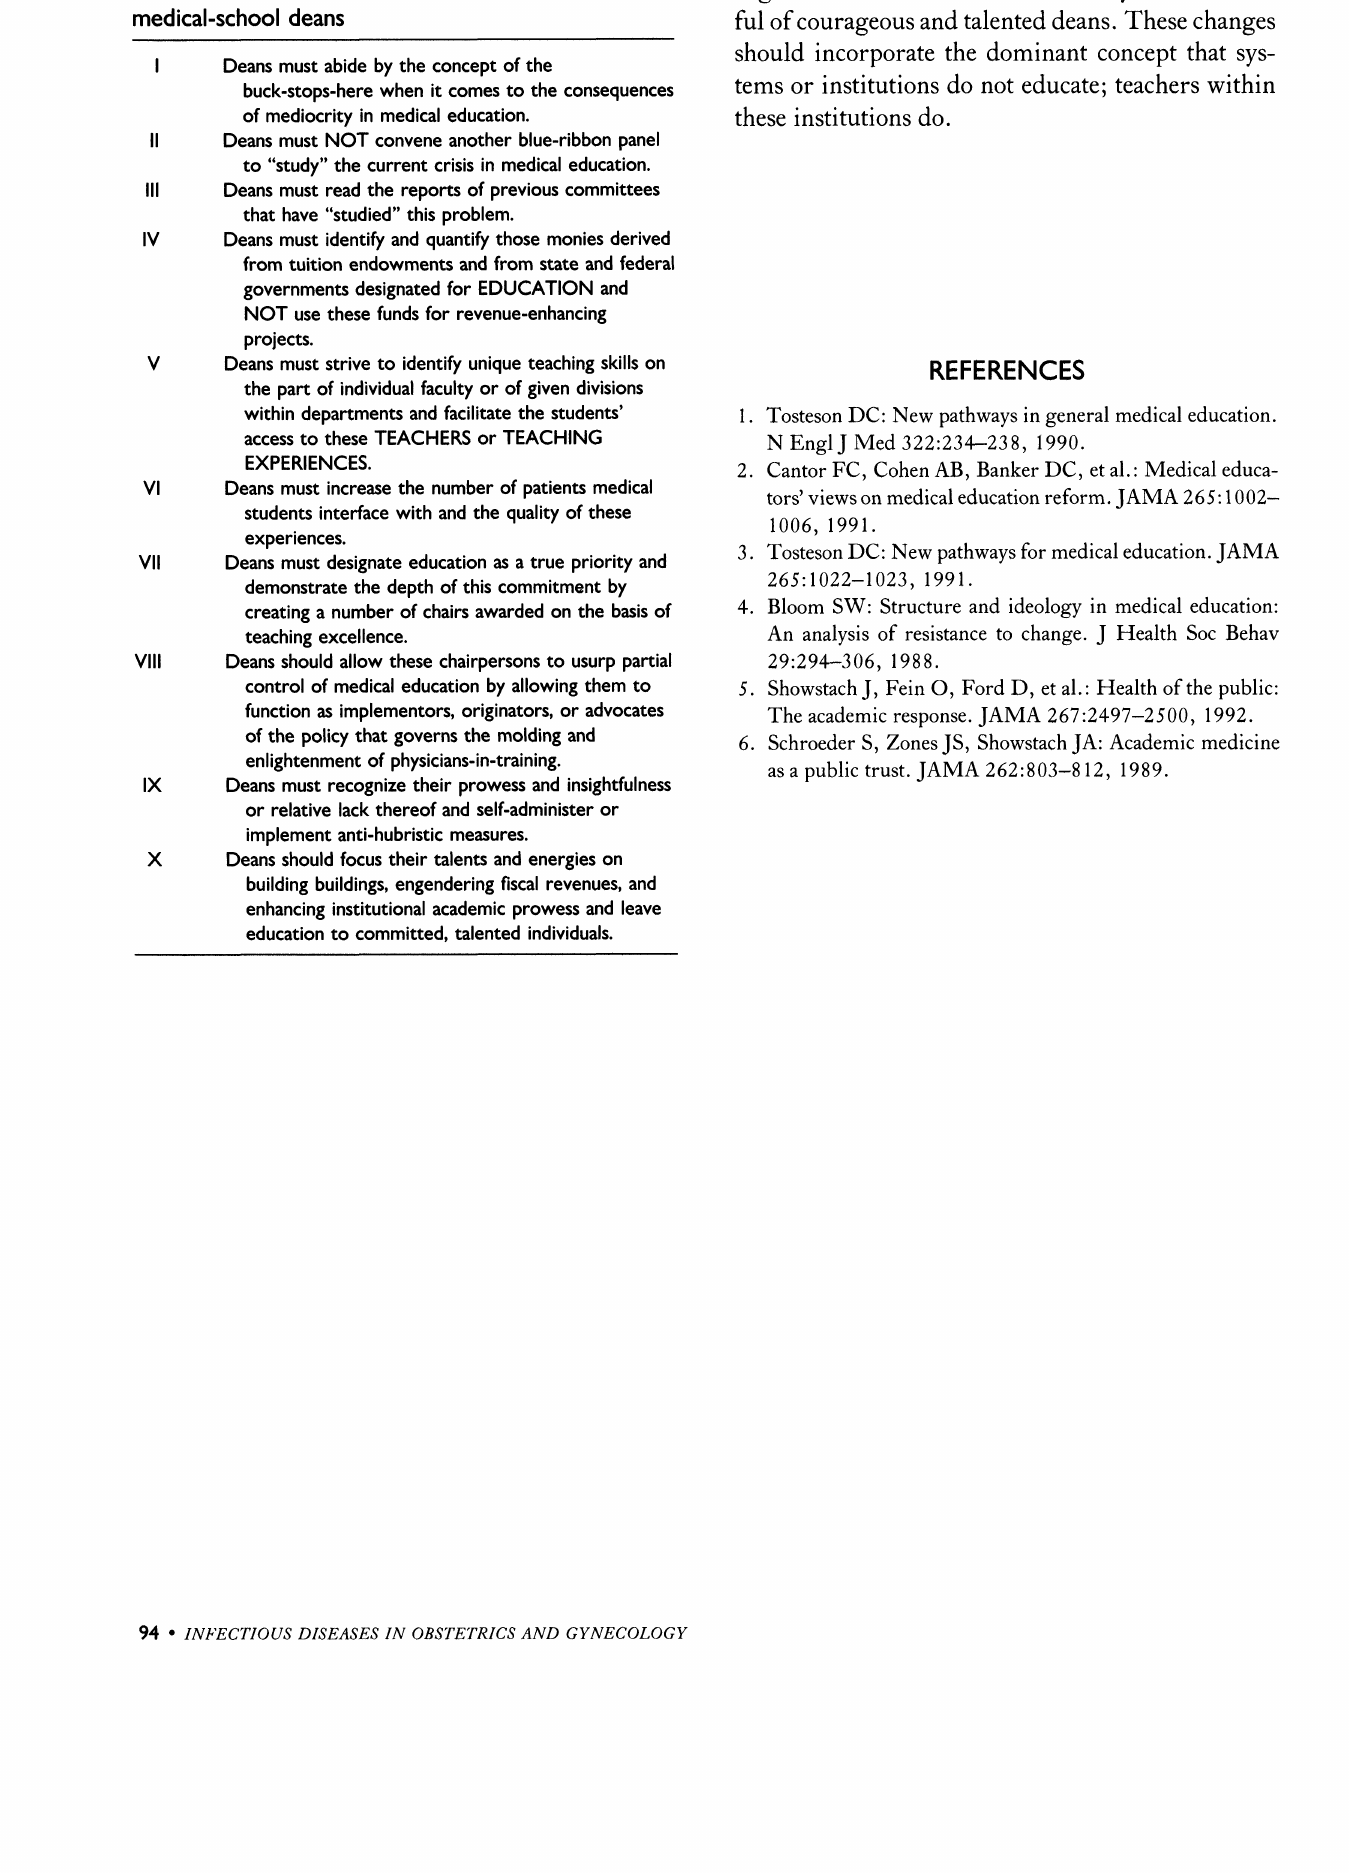
TABLE I. Ten educational commandments